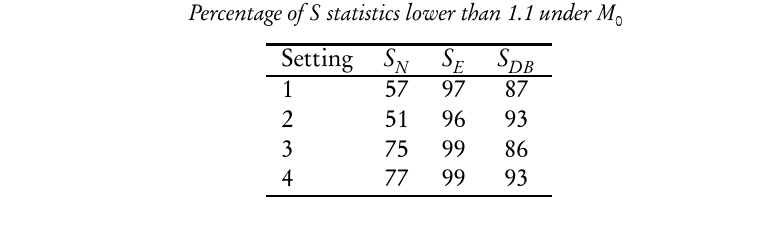
Percentages of various S statistics lower than 1.1 under different alternative hypotheses Hypothesis